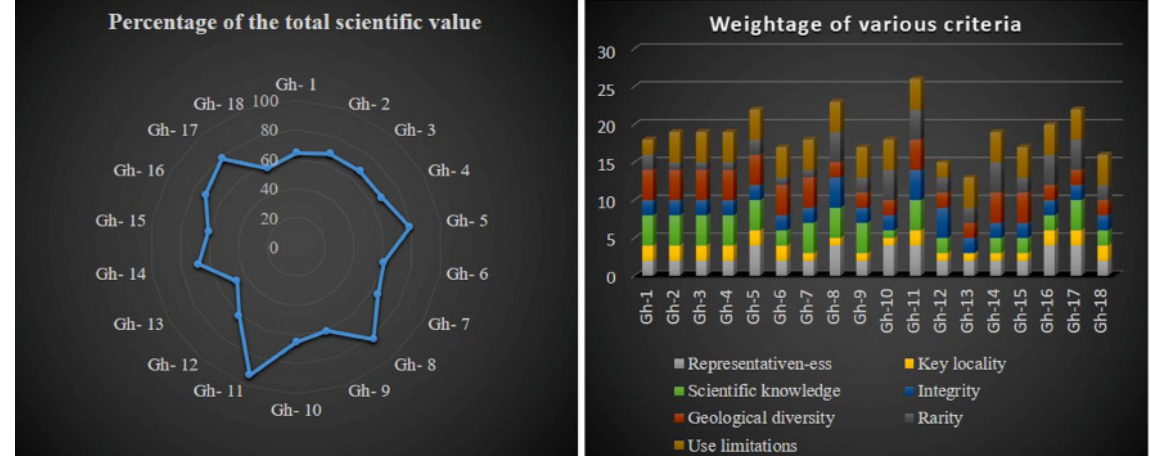
Figure 12. Assessment of the 18 geosites of Kachchh Province, Gh-1 to Gh-18, for scientific value. Percentage of the scientific value (left) and weighting of various criteria of scientific value